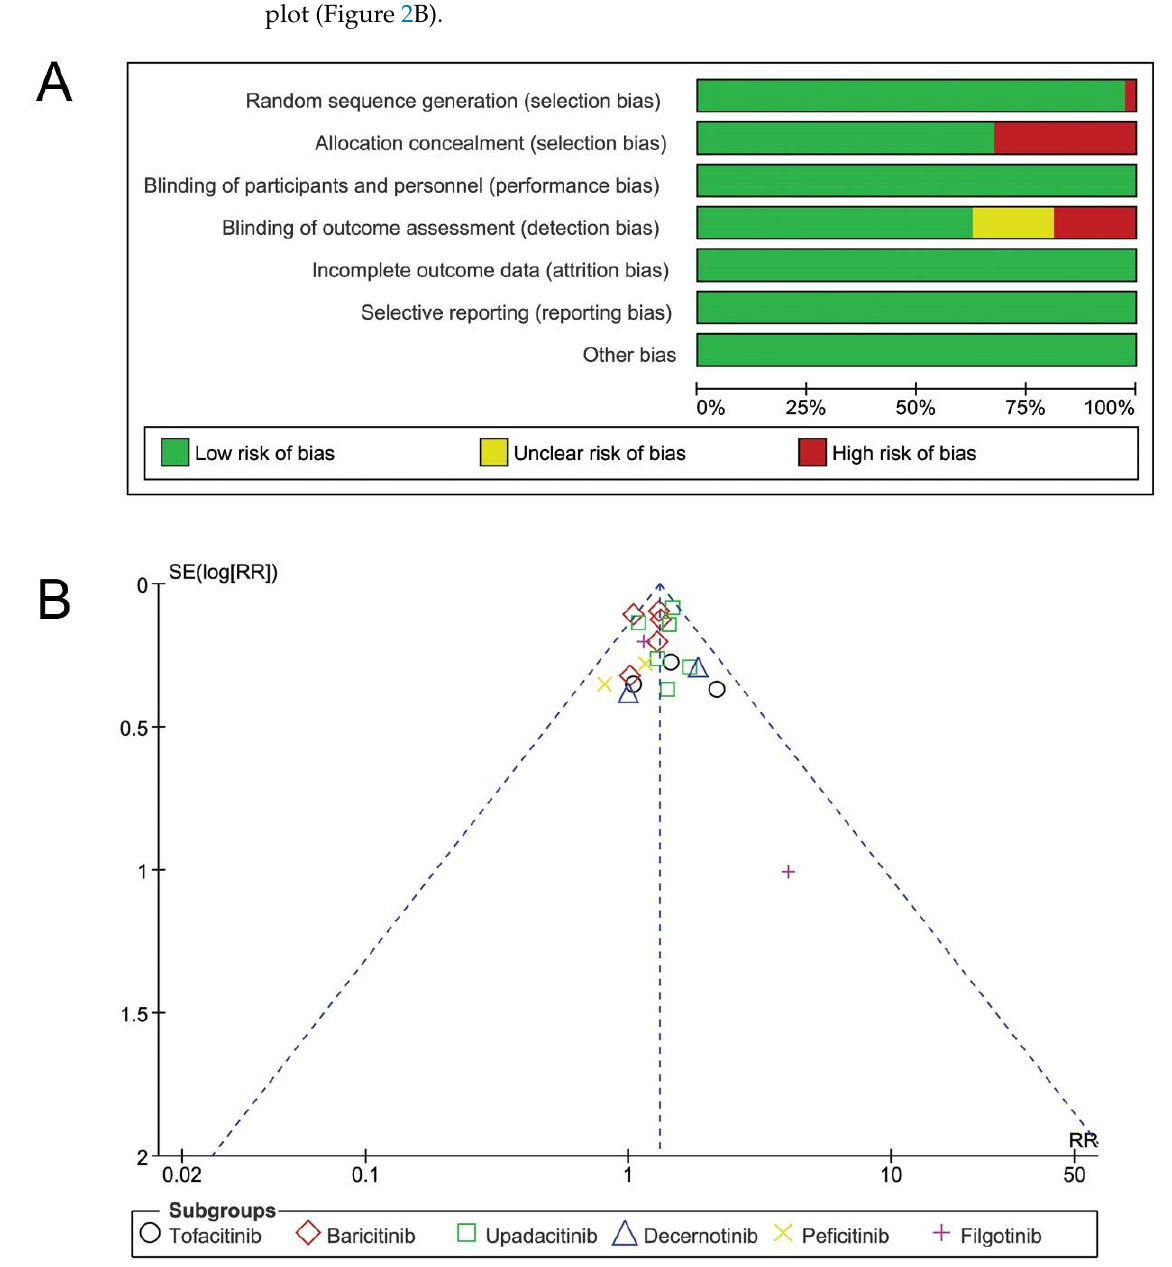
Figure 2. The risk of bias assessment and publication bias. ( A ) Risk of bias summary of included trials; ( B ) funnel plot of the included trials evaluating the effect of JAKinibs on adverse events. RR = relative risks.